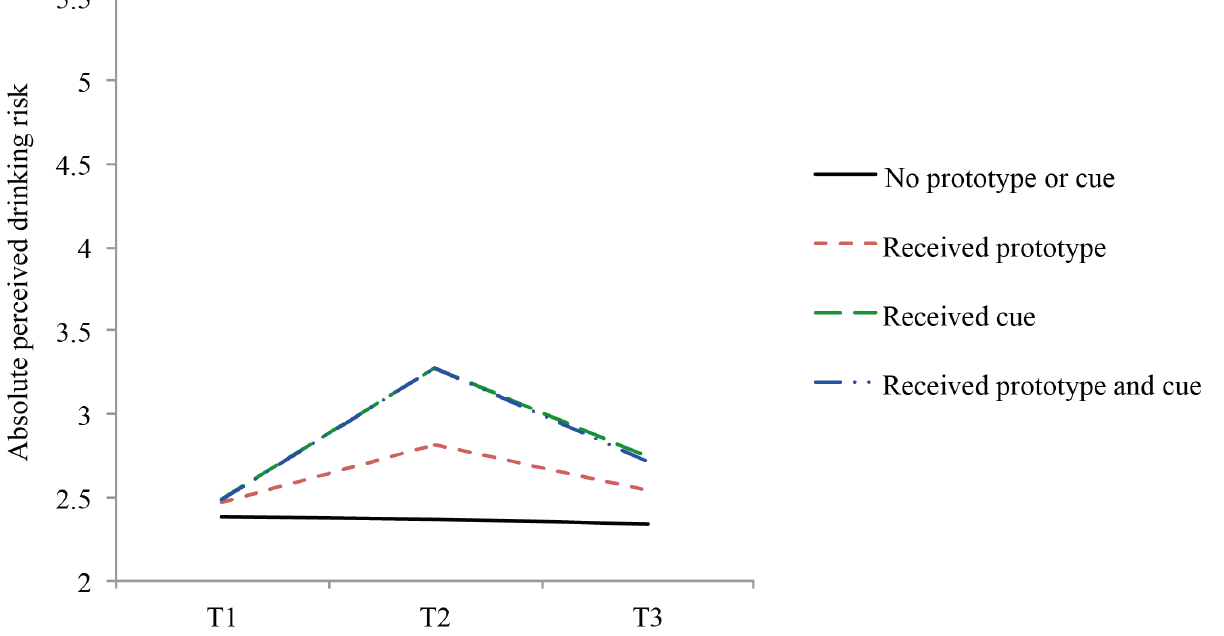
Figure 4. Effects on absolute perceived drinking risks per analysis group (means) at baseline (T1), 1-month posttest (T2), and 6-month follow-up